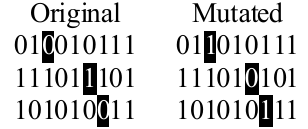
Figure 6. Flowchart of the GA Fig. 6. Flowchart of the GA.